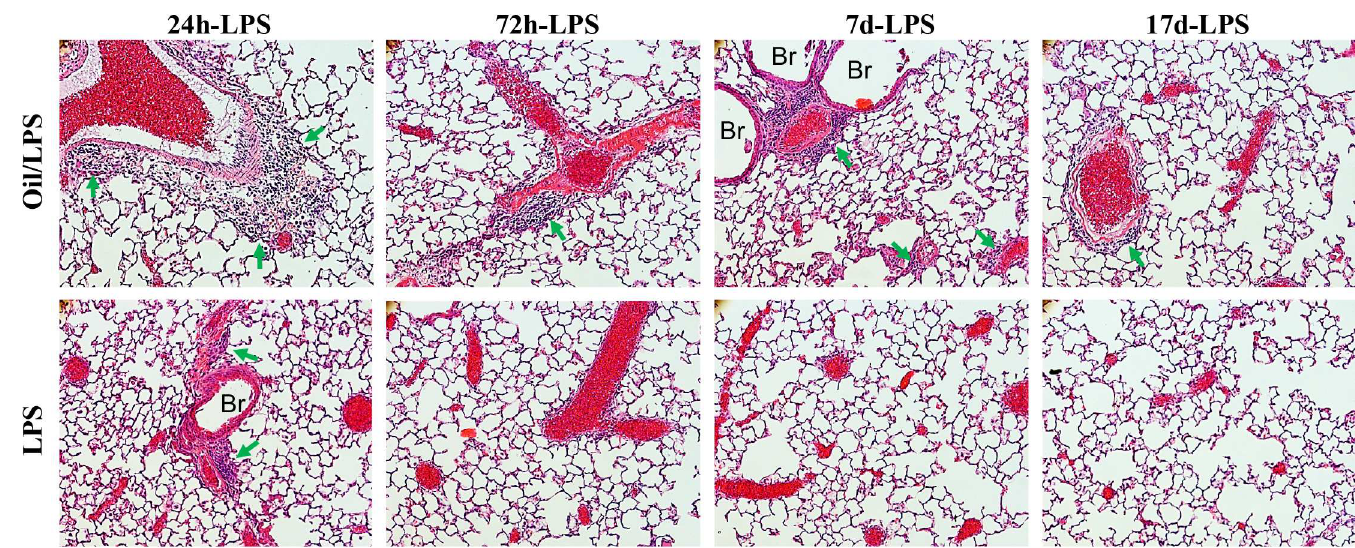
Fig 3. Histological analysis. Representative micrographsof H&E-stained mouse lungsections. At 24 hours post-LPS challenge,leukocyte sequestration was evidentin mouse lungs of both LPS and oil/LPS groups. At 72 hours post-LPS challenge, leukocyte infiltration was minimal in lungs of oil-free mice but remained markedly elevated in lungs of corn oil-loadedmice. Even at 17 days post-LPS challenge, leukocyte sequestration in mouse lungs was still prominent in oil/LPS mice, indicatingpersistent lung inflammation in oil/LPS mice over 2 weeks. Arrows indicateleukocyte infiltration.Red cells are red blood cells. Scale bar, 50 μ